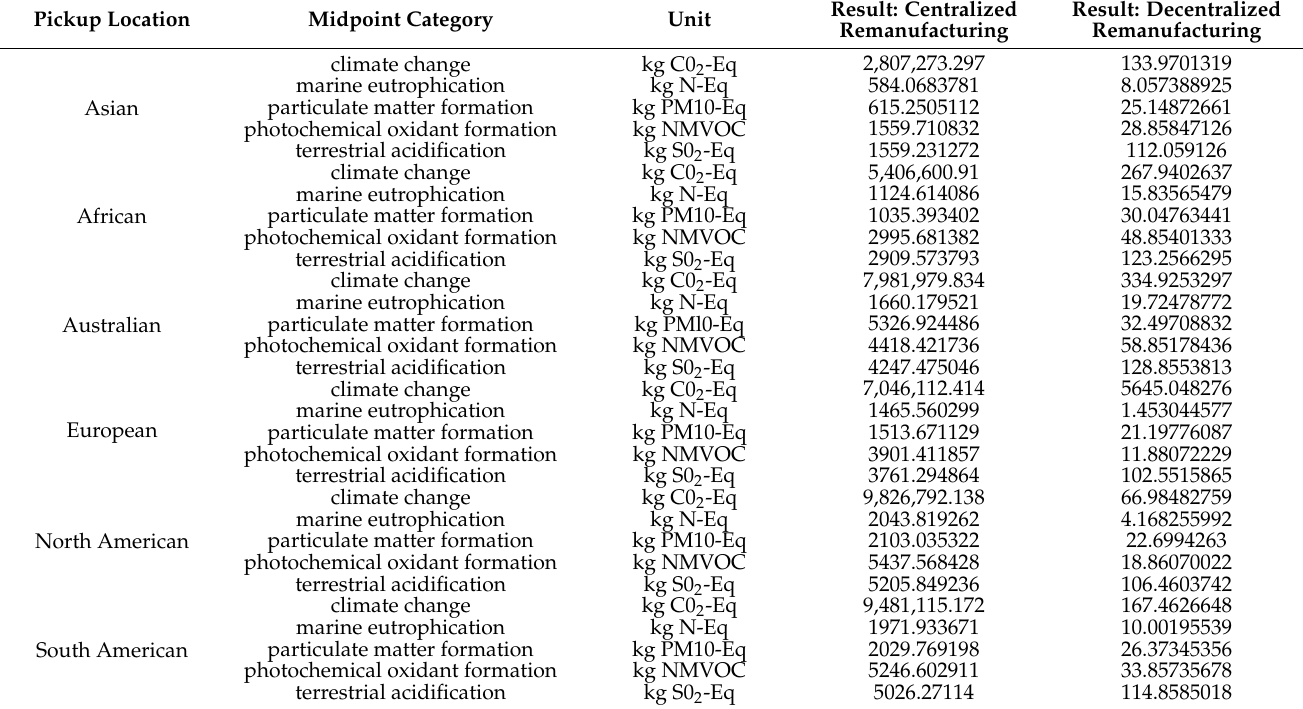
Table 7. Result of LCA for a single laptop in both supply chains.